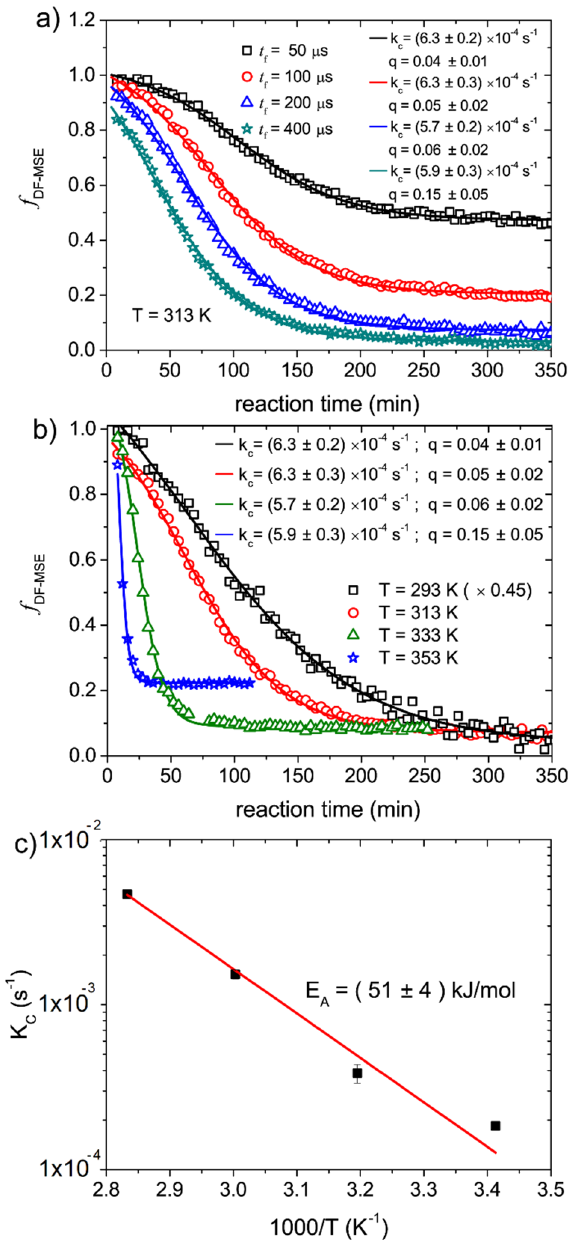
Figure 4. ( a ) Mobile fractions as function of the reaction time during the epoxy cure, calculated from DF-MSE experiments with different filter times. Best fit curves using Equation (3), as well as the obtained values for k C and q , are also shown. The values obtained for f 0 are all equal to 1.0 ± 0.1. ( b ) Mobile fractions as a function of the reaction time during the epoxy cure at different temperatures calculated from DF-MSE experiments. For better visualization, the curve for 293 K was scaled up by a factor of 0.45. Best fit curves using Equation (3), as well as the obtained values for k C and q , are also shown. The values obtained for f 0 at all temperatures using the first mixed-MSE echo are equal to 1.01 ± 0.01. The drop in f DF − MSE due to the partial suppression of the mobile phase was taken into account by the γ factor in Equation (3). ( c ) Arrhenius plot of the k c values obtained from the fits shown in ( b